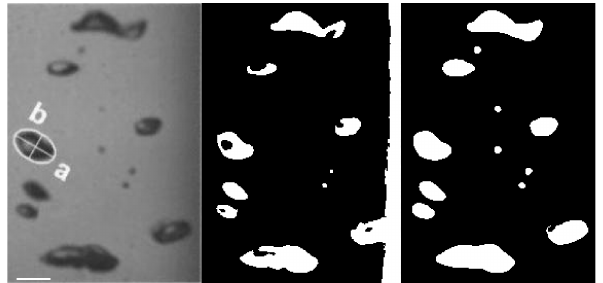
Fig. 2. Left; Inhomogeneously illuminated grey scale image. Pa- rameter “ a ” and “ b ” denote the major and minor axis of a best fit ellipse encircling the bubble. The white scale bar has a length of 10mm. Centre; Bubble segmentation using the threshold method. Right; Bubble segmentation applying the edge detection method. The edge detection method results in an accurate representation of the bubbles and is, in addition, less sensitive to inhomogeneous background illumination compared to the threshold